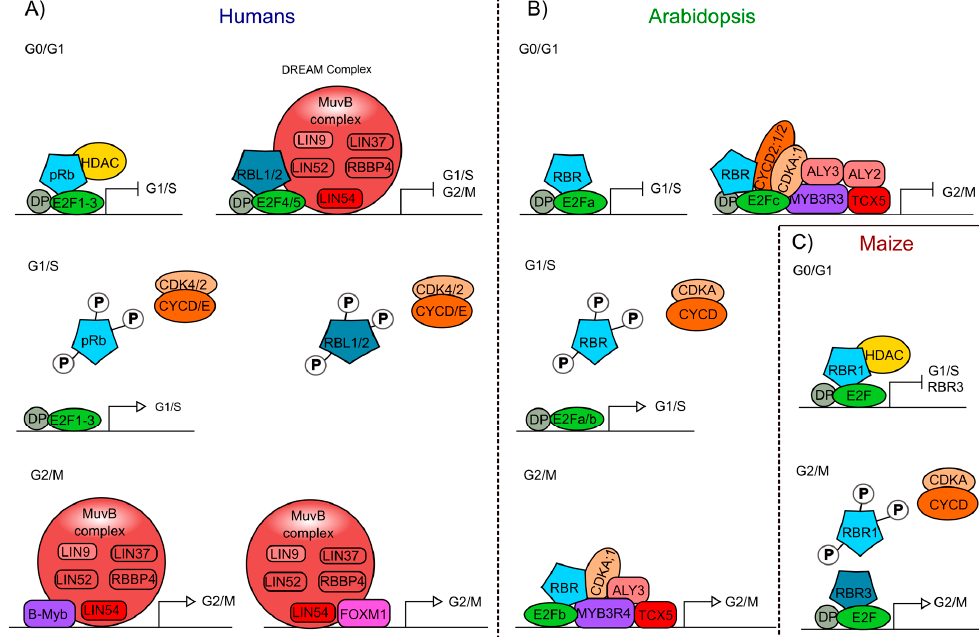
Figure 2. Interaction of the Retinoblastoma protein involved in cell cycle regulation of humans and plants. ( A ) pRb- and pRBL1/2-containing protein complexes from humans, formed at different stages of the cell cycle (G0/G1; G1/S; G2/M). ( B ) Arabidopsis protein complexes formed at different stages of the cell cycle (G0/G1; G1/S; G2/M), including AtRBR as a component. ( C ) Maize protein complexes formed at different stages of the cell cycle (G0/G1; G2/M), involving the ZmRBR proteins (RBR1 and RBR3) as components. Similar components in humans, Arabidopsis, and maize are displayed using the same colors: Rb proteins (blue), E2F transcription factors (TFs) (green), DP (grey), cyclins (CYC), and cyclin-dependent kinases (CDK) (orange), Muv complex proteins (red and pink), Myb TFs (purple), FOXM1 TF (pink).